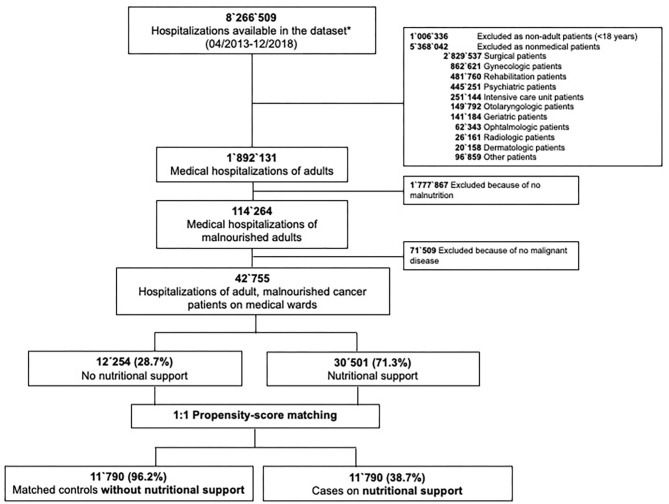
Study flow sheet.